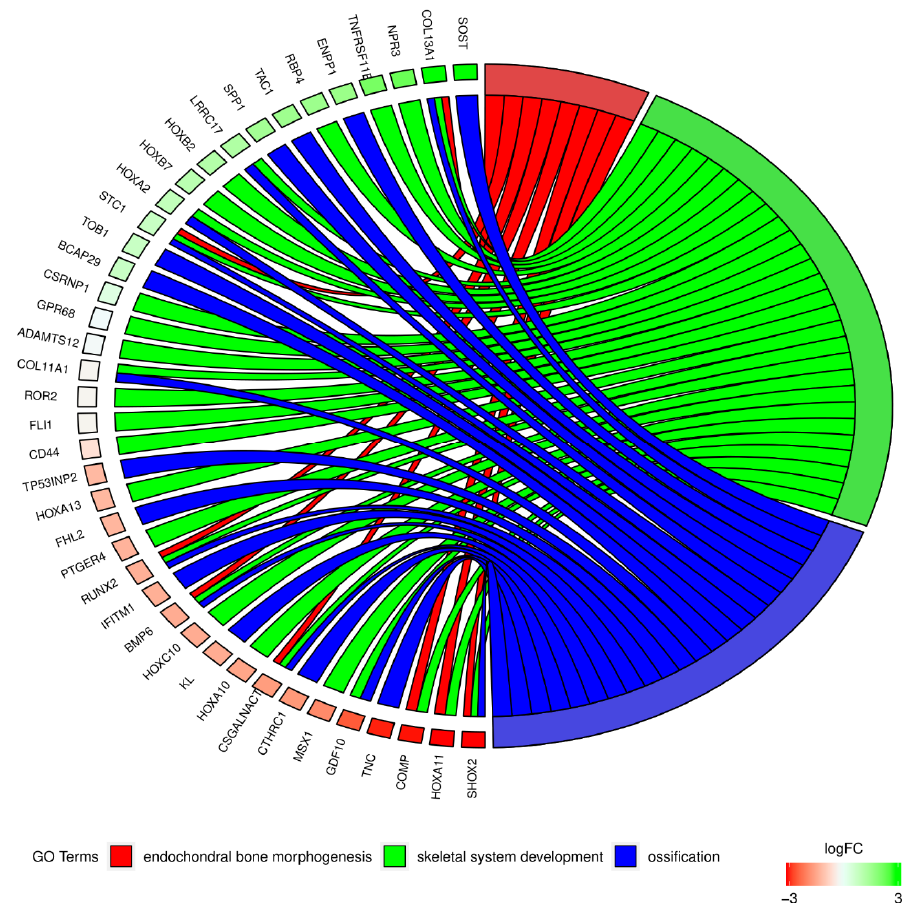
Figure 3. The representation of the mutual relationships between genes, which include “endochondral bone morphogenesis”, “ossification”, and “skeletal system development” GO BP terms. The ribbons show the genes belonging to the given categories. The color bars near each gene correspond to logFC between the vein and artery. The genes were sorted by logFC.